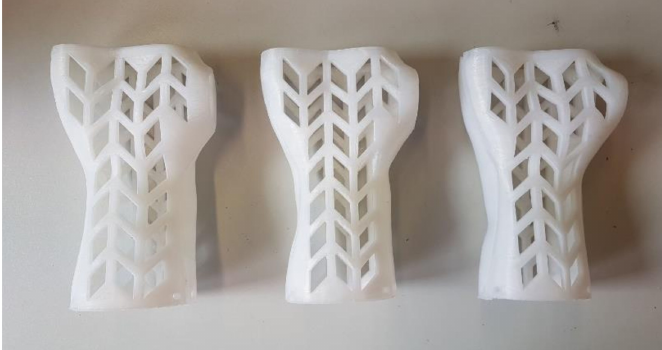
Figure 11. Orthoses manufactured vertically from nylon, strategies. ( left to right ) Econo, accura,